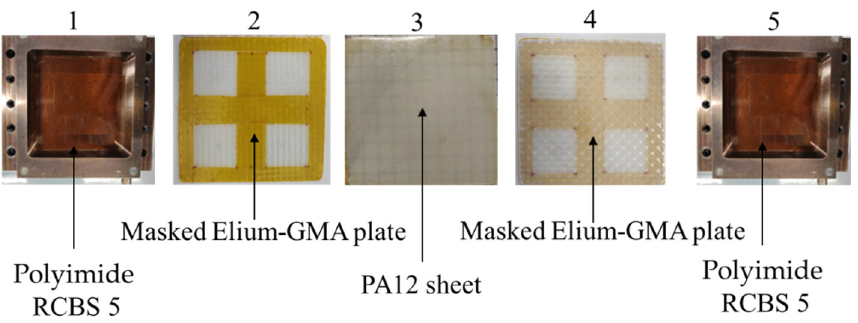
Figure 4. Sequence of layers arranged in the mold. 1- layer of polyimide RCBS5, 2- a masked Elium ® -GMA plate, 3- a PA12 sheet, 4- a masked Elium ® -GMA plate, 5- layer of polyimide RCBS5.